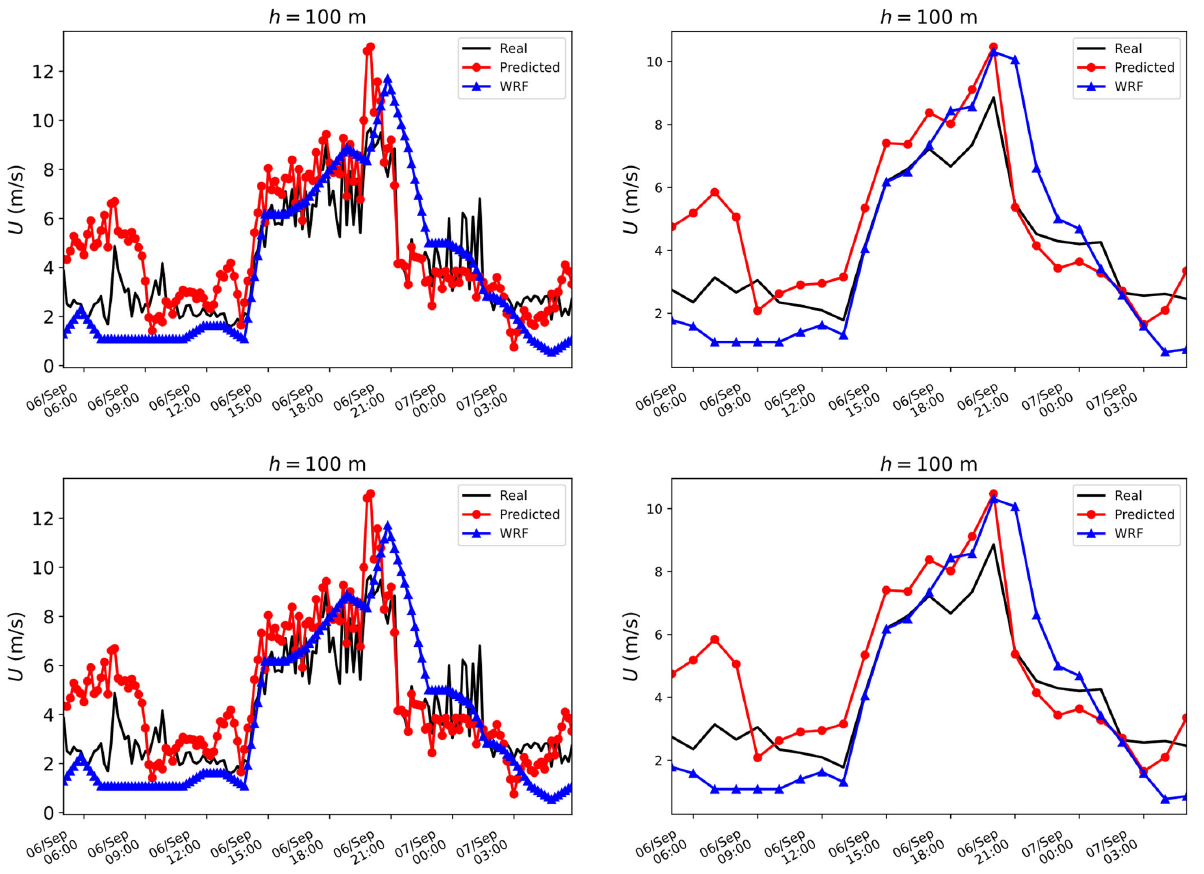
Figure 4. Simulated and real temporal series of the wind speed at h = 81 m using the bagging regressor: ( Left ) 10 min averaged values; ( Right ) hourly averaged values.